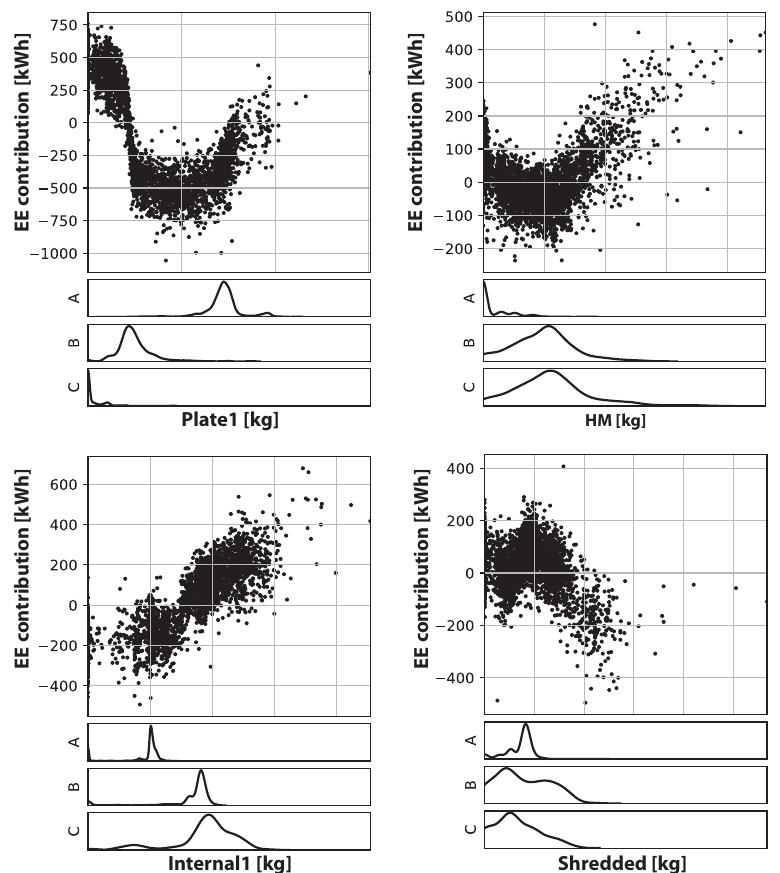
Figure 9. SHAP main interactions on EE by Plate1, Internal1, HM, and Shredded scrap categories. The three probability density plots below each plot show the distribution of the scrap category for each of the charge types A, B, and C, respectively. See Section 3.5.3 for an explanation of the different steel types. The y-axis of the scatter plot shows the SHAP main interactions on EE for each variable and the y-axes of the probability density plots show the frequency of each charge weight. The x-axes of both the SHAP plot and the probability density plot for each charge type are the amount charged of the scrap category. The values on the x-axes has been omitted due to proprietary reasons. The values governing the plots are from both the training and test